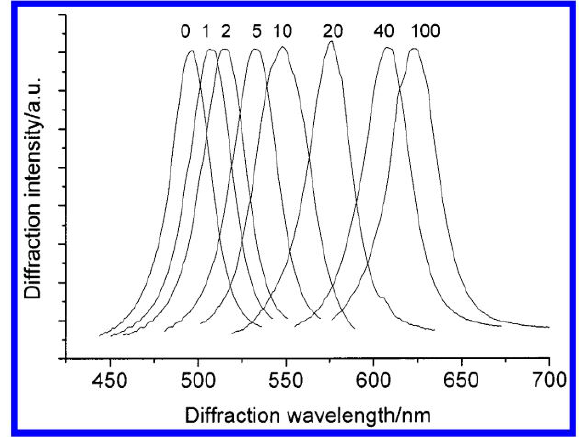
Figure 11. Glucose concentrations from 0 to 10 mM